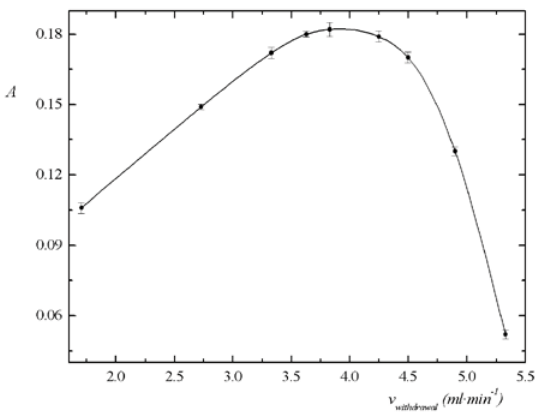
Figure 3. The dependence of the absorption signal on withdrawal flow rate for cell D : I = 0.25 A, v